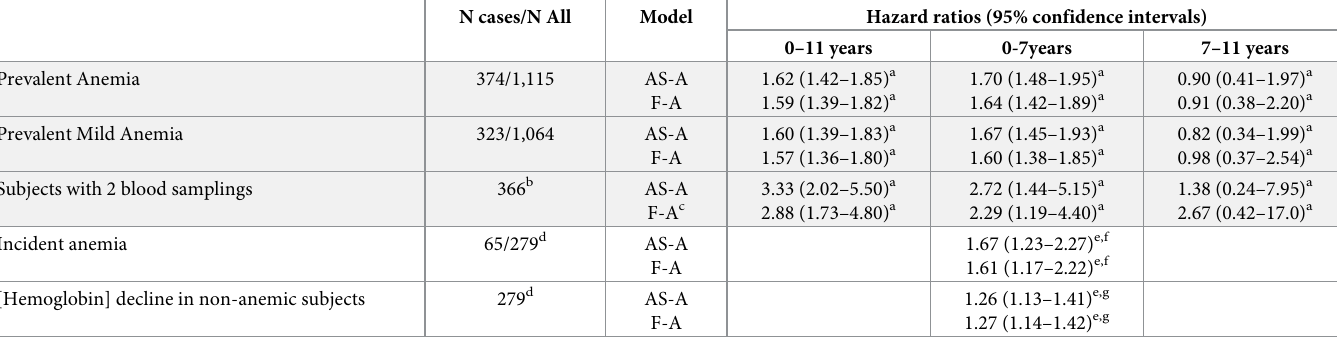
Table 5. Risk of mortality associated with prevalent anemia, incident anemia, and decline in hemoglobin concentration in old-old participants in the Monzino 80-plus